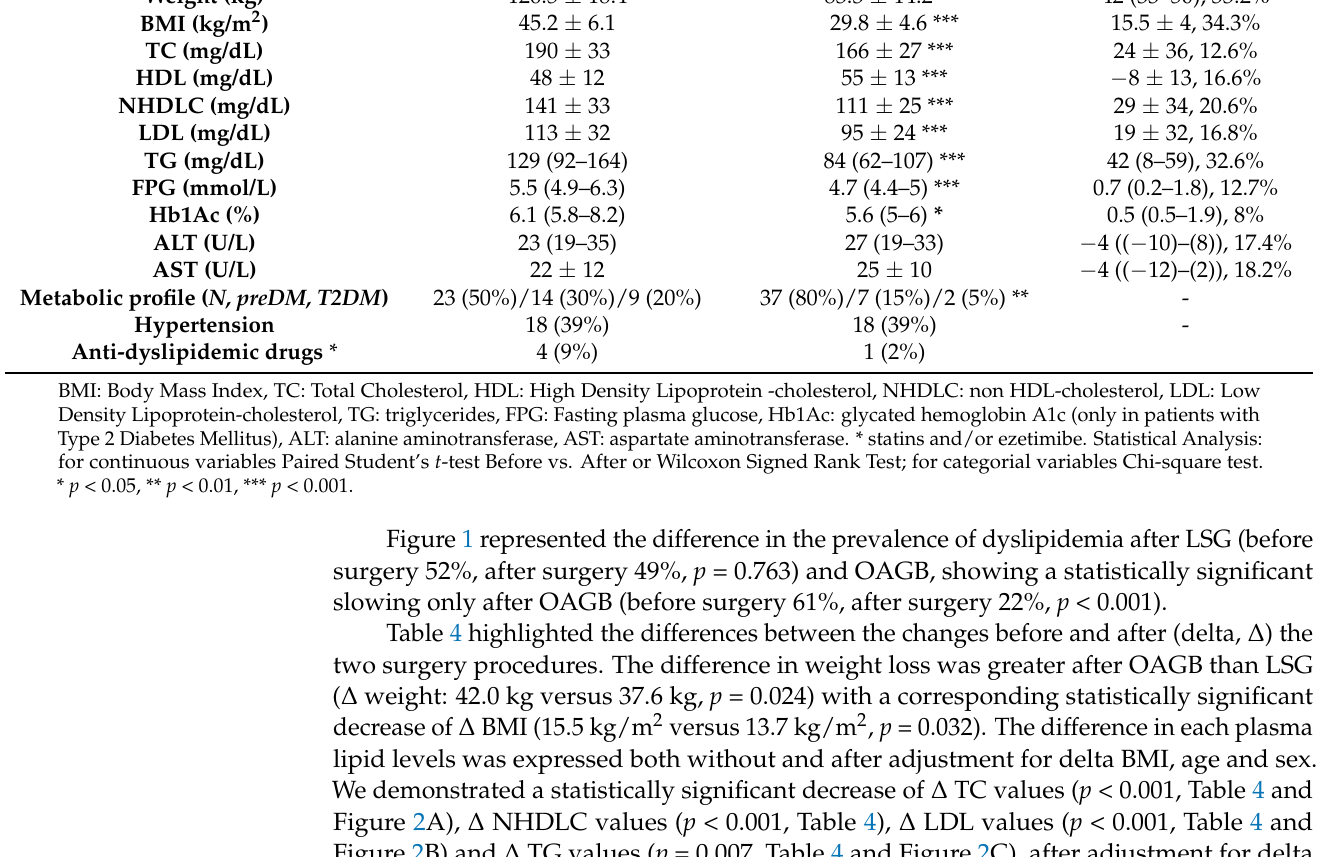
Table 3. Anthropometric, biochemical parameters and comorbidities change 18 months after One Anastomosis Gastric Bypass in 46 patients.